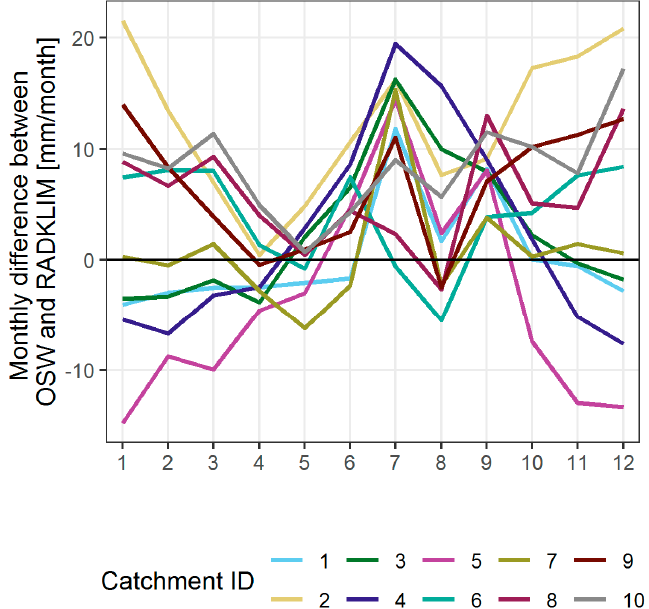
Figure 7. The average differences of monthly precipitations from OSW and RADKLIM for the ten selected catchments in the study period selected catchments in the study period (2001–2017).